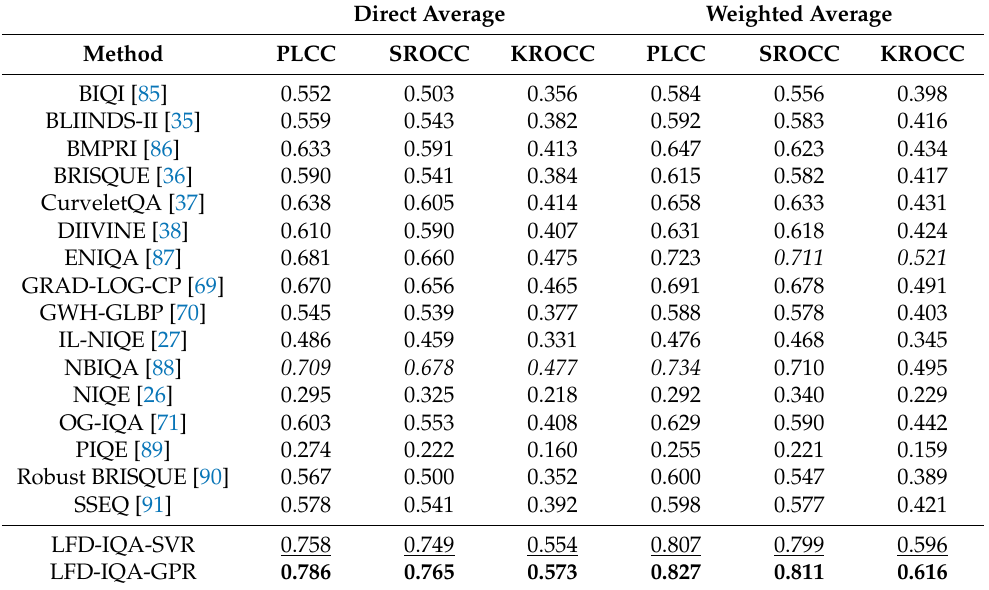
Table 5. Direct and weighted average of PLCC, SROCC, and KROCC performance metrics. The best results are typed in bold, the second best results are underlined, and the third best results are typed in